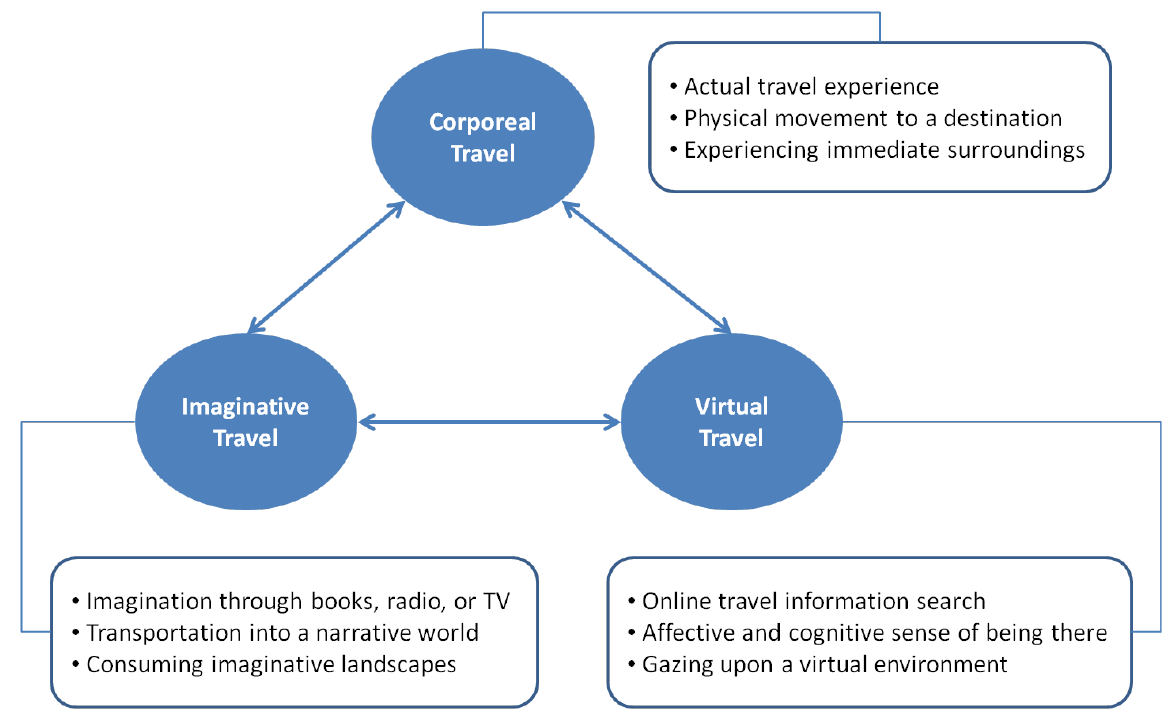
Figure 1. Relations between Corporeal, Imaginative, and Virtual Travel